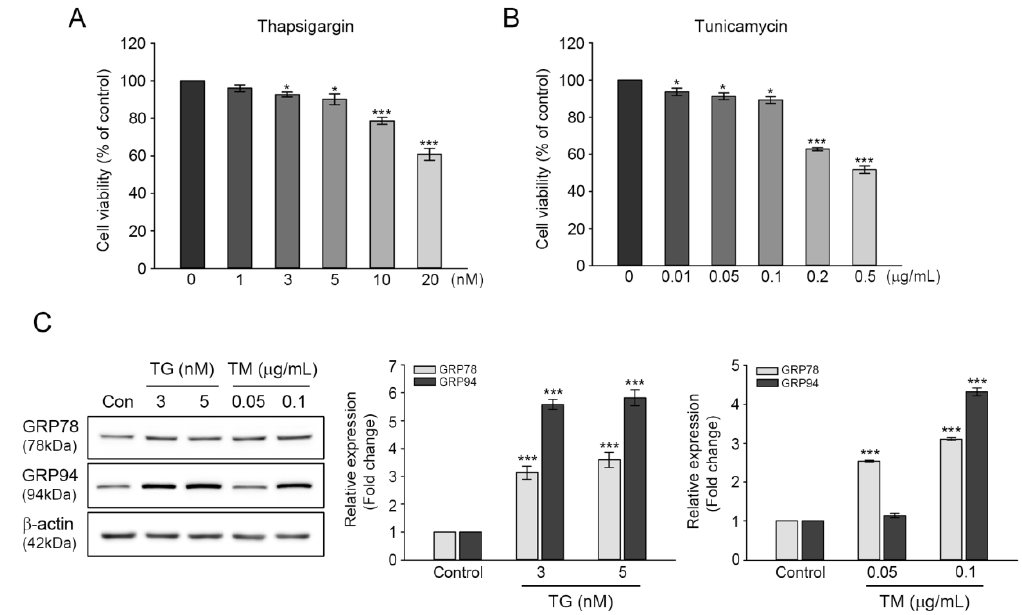
Figure 2. Induction of GRP78 and GRP94 expression in thapsigargin (TG)- or tunicamycin (TM)-treated HEI-OC1 cells. ( A ) Cytotoxicity was mediated by 1–20 nM TG ( A ) or 0.01–0.5 µ g / mL TM ( B ) treatment for 24 h. Values are expressed as means ± SE of four independent experiments, expressed as a percentage of untreated control values. * p < 0.05, *** p < 0.001, compared with the untreated control. ( C ) Cells were treated with 3 and 5 nM TG, or 0.05 and 0.1 µ g / mL TM for 24 h, followed by immunoblot of GRP78 and GRP94 expressions. Individual bands were quantified densitometrically and normalized to β -actin. The values in a graph are represented as fold changes relative to the untreated control, expressed as means ± SE of three independent experiments (*** p < 0.001).